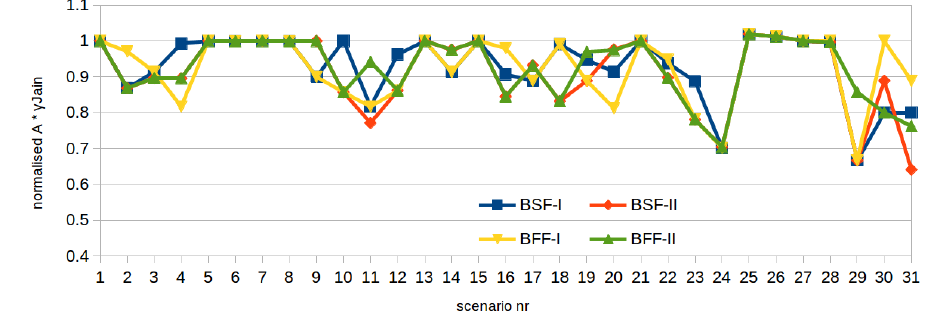
Figure 24. Product of efficiency and Jain’s fairness index, normalized by NFF, for different fair allocation methods, based on the numerical results in Tables